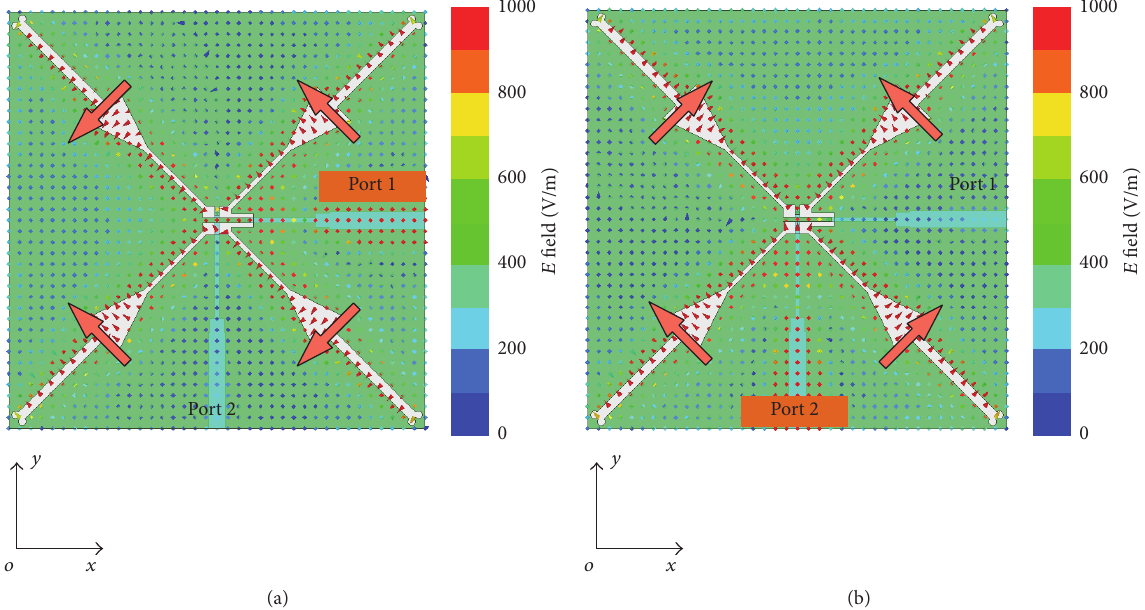
Figure 10: Electric-field distributions of the proposed antenna for (a) Port 1 and (b) Port 2.